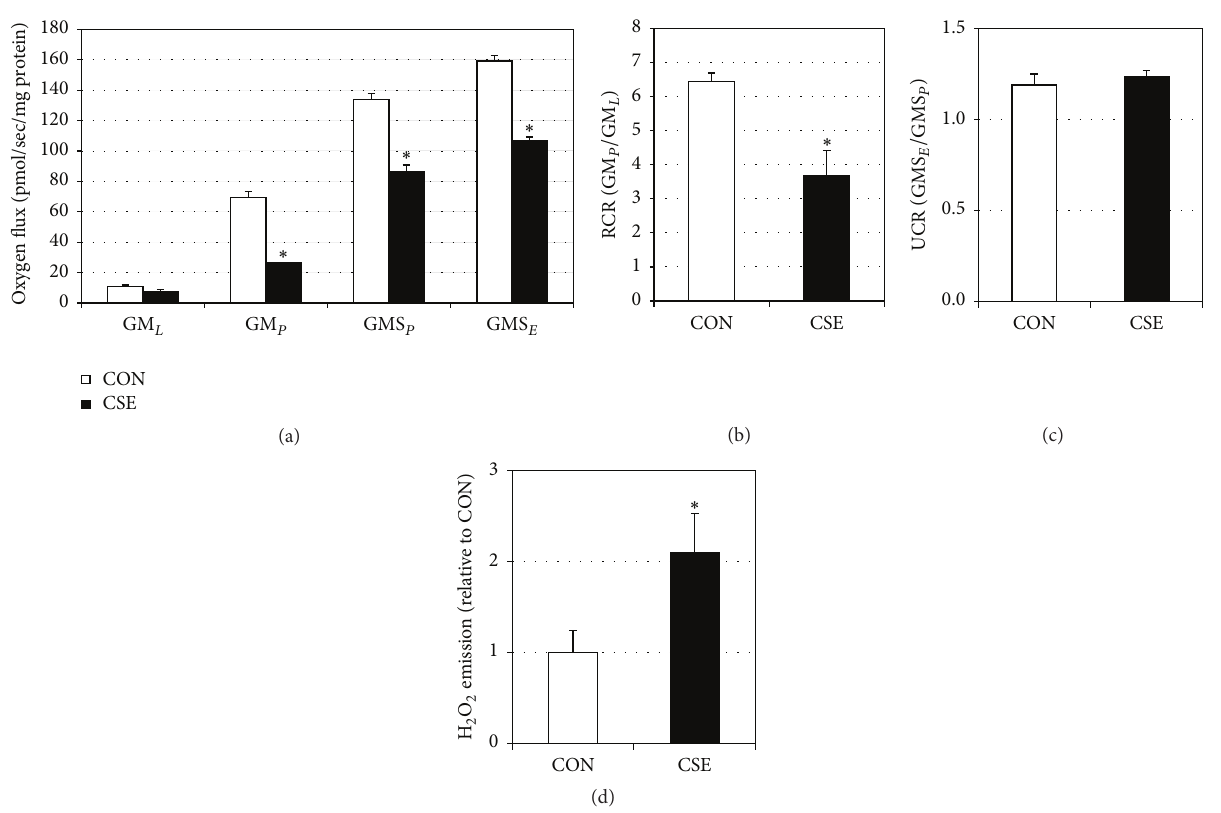
Figure 1: CSE-treated gingival cell conditioned medium alters myotube mitochondrial function. Myotubes were treated with conditioned medium (12h) from gingival cells that had previously been treated with normal medium (CON) or cigarette smoke extract (CSE). To measure : glutamate (10mM) + malate (2mM); GM : + ADP (2.5mM); GMS : + mitochondrial respiration ((a); 𝑛 = 6 ), cells were treated with GM L D D : + FCCP (0.05 𝜇 M). Respiratory control ratio (RCR; (b)) and uncoupling control ratio (UCR; (c)) were determined succinate (10mM); GMS F by the analysis indicated. In separate experiments, myotubes were incubated with MitoTracker and imaged for analysis of H 2 O 2 production ((d); 𝑛 = 5 ). ∗ 𝑃 < 0.05 : CSE versus